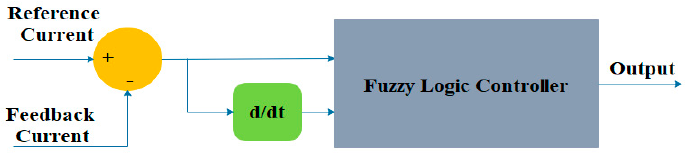
Figure 34. Current control for type 4 hybrid controller.